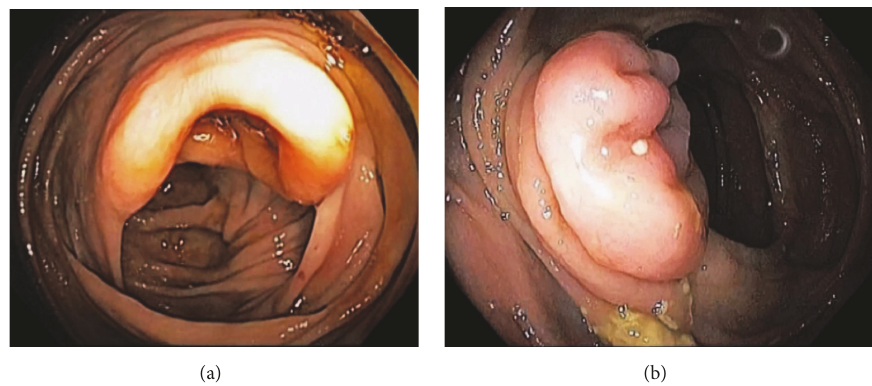
Figure 3: Endoscopic images of the ileocecal valve in labial (a) and papillary (b) forms.